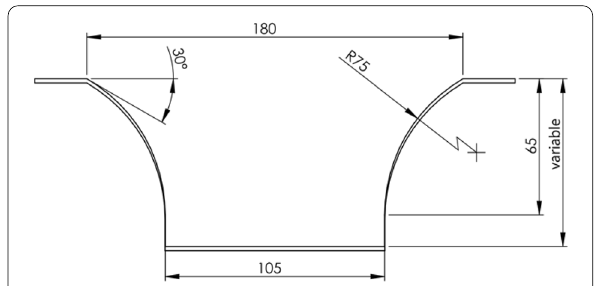
Figure 2 Example of a constant varying wall thickness part (or Frustrum of a cone), to evaluate the maximum forming wall angles during